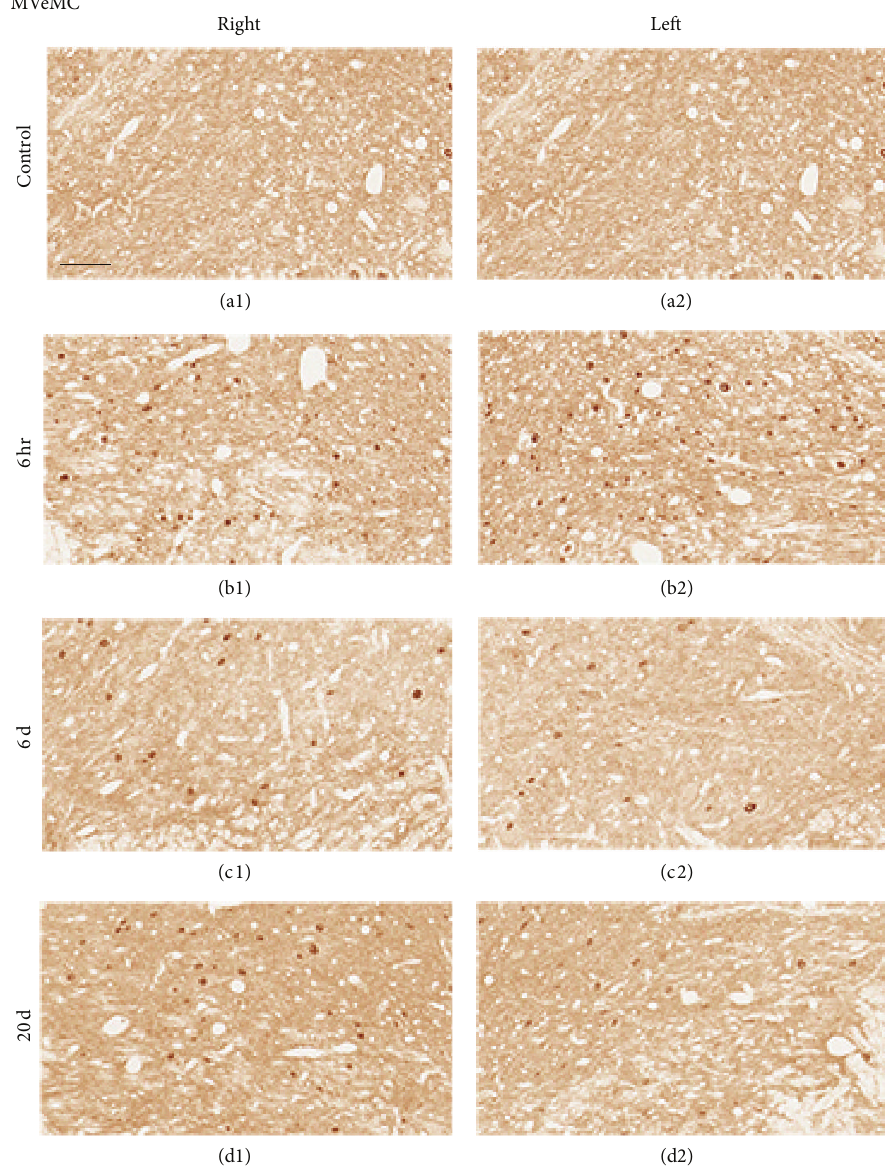
Figure 9: Representative photomicrographs showing c-Fos immunoreactivity in the MVeMC (Bregma − 11.60mm) of rats that underwent cochleostomy at 1 and 3 hours and 6 and 20 days. Bilaterally increased c-Fos-positive cells were observed at 6 hours (b1 and b2), 6 days (c1 and c2), and 20 days (d1 and d2) relative to controls (a1 and a2). (a1), (b1), (c1), and (d1): right side; (a2), (b2), (c2), and (d2): left side. Scale bar = 40 𝜇